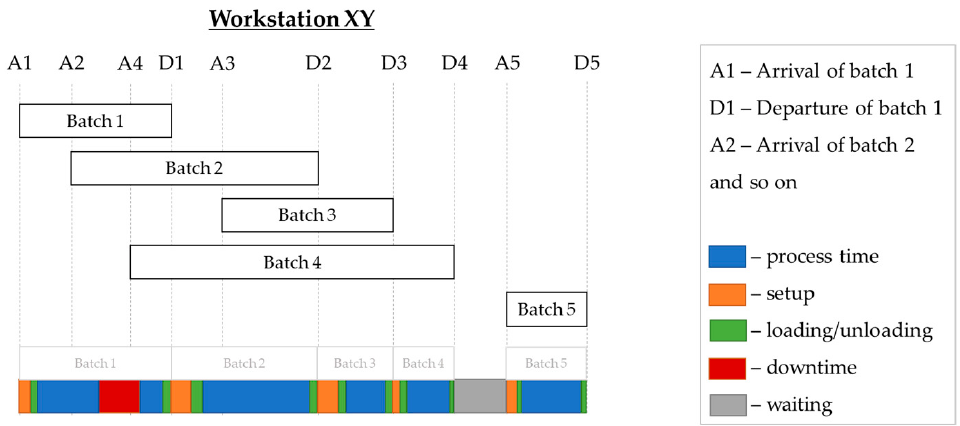
Figure 3. Capturing the states of a workstation-extended approach compared with that of Jacobs, J. H. et al.